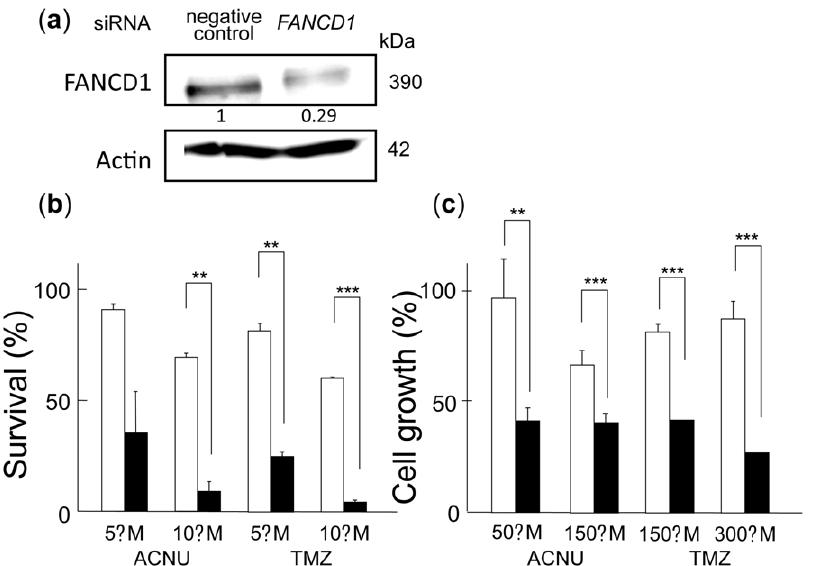
Figure 5. siRNA silencing of FANCD1/BRCA2 in glioblastoma A172 cells after ACNU and TMZ treatments. a , expression analysis of FANCD1/BRCA2 in cells transfected with siRNA for human FANCD1/BRCA2 or the negative control siRNA using Western blots. Actin was used as a loading control, and the relative ratios of protein were normalized using actin levels. b , effect of siRNA silencing of FANCD1/BRCA2 on cellular sensitivity to ACNU and TMZ. c , effect of siRNA silencing of FANCD1/BRCA2 on cell growth after ACNU or TMZ treatment. Open columns, negative control siRNA; closed columns, FANCD1/BRCA2 siRNA. Columns show the mean of three independent experiments; the bars indicate the SD. An asterisk (*) indicates significant difference ( P , 0.05). Two asterisks (**), P , 0.01; three asterisks (***), P , 0.001.